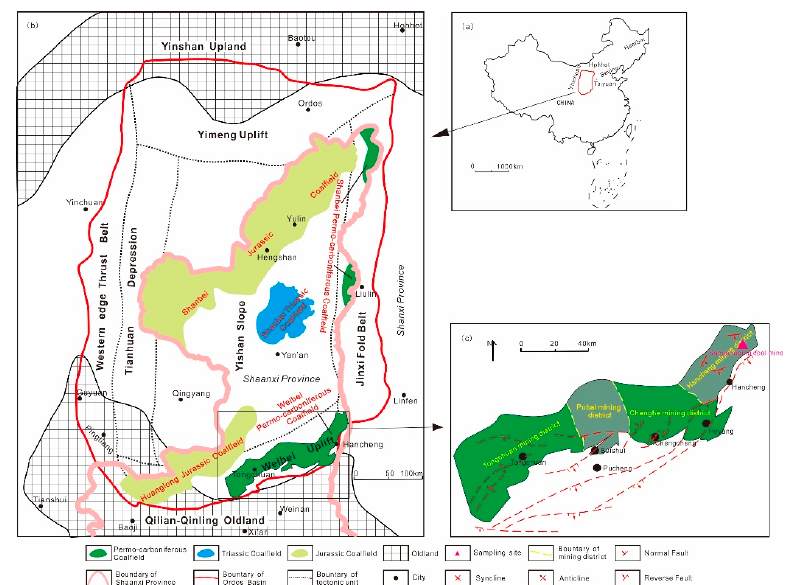
Figure 1. Location of the Sangshuping mine in Hancheng mining district, Weibei coalfield (modified from Li et al., 2020 [31]). ( a ) Location of the Ordos basin; ( b ) location of Weibei coalfield in the Ordos basin; ( c ) sampling sites in the Sangshuping mine, Hancheng mining district of the Weibei coalfield. Energies 2020 , 13 , x FOR PEER REVIEW